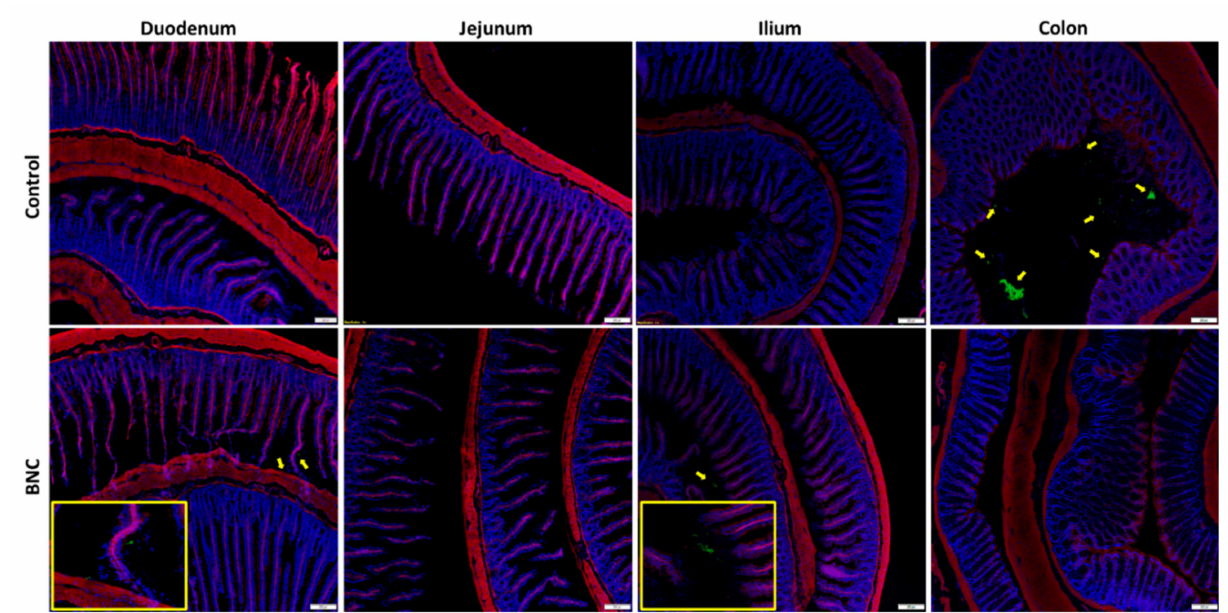
Figure 9. FM images of a male rat histological sample after a 21-day repeated-dose study. Four GIT regions (duodenum, jejunum, ilium and colon) were stained for nuclei (blue), actin cytoskeleton (red) and cellulose (green). Control (no gavage) and BNC (oral gavage) animals. Cellulose fibers were detected at the intestinal lumen or trapped between the villi (pointed out by the yellow arrow and the respective amplified image in the yellow box). Scale bar: 200 µ